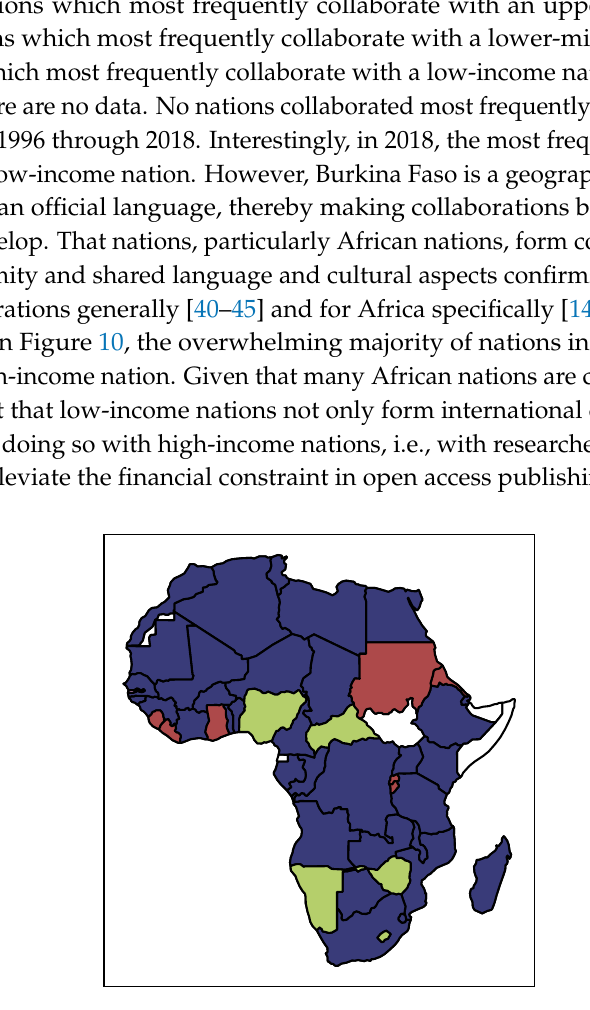
Figure 10. A map portraying the income groups of the most frequent collaborators of African nations. Nations colored in blue most frequently collaborate with high-income group nations, nations in green most frequently collaborate with upper-middle-income group nations, nations colored in red most frequently collaborate with lower-middle-income group nations, and nations colored in white did not have publications in the data